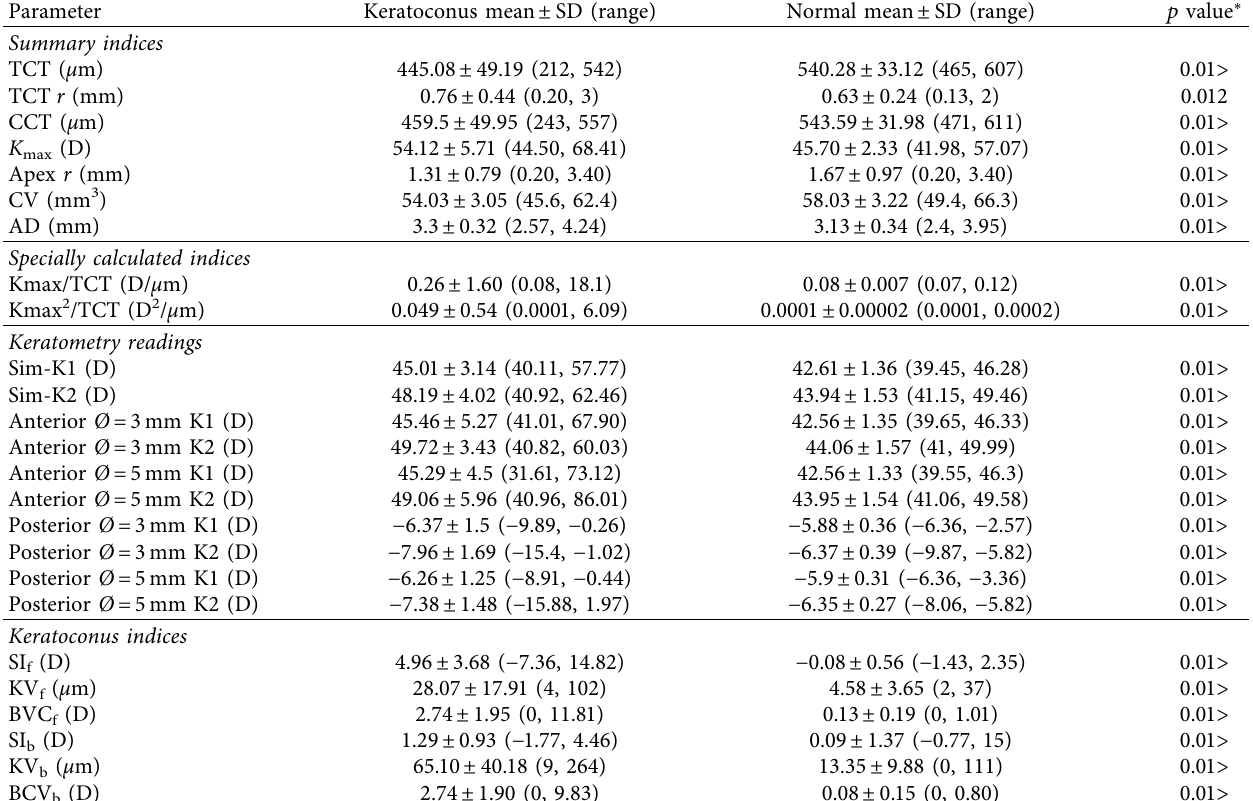
Table 1: The mean values of summary indices, keratoconus indices, specially calculated indices, keratometry readings, and keratoconus indices in keratoconus and normal groups.